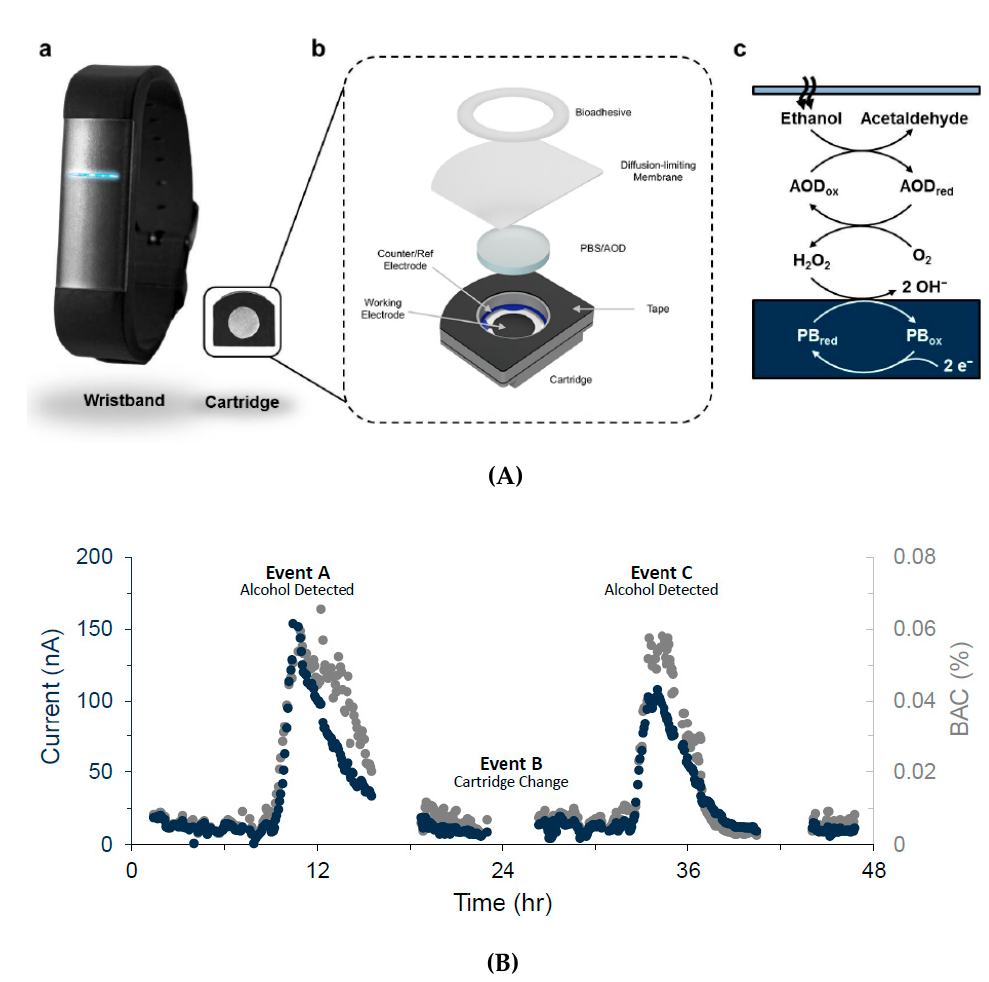
Figure 31. ( A ) The wristband sensor with its disposable cartridge (a); Scheme of the disposable sensor’s components (b); Amperometric detection principle, using alcohol oxidase and Prussian blue. ( B ) Current measurements using the developed device (grey) and derived equivalent blood alcohol concentration (black), for two periods of 24 h, interrupted by the necessary change of the disposable cartridge. Reproduced from [93]. Creative Commons Attribution